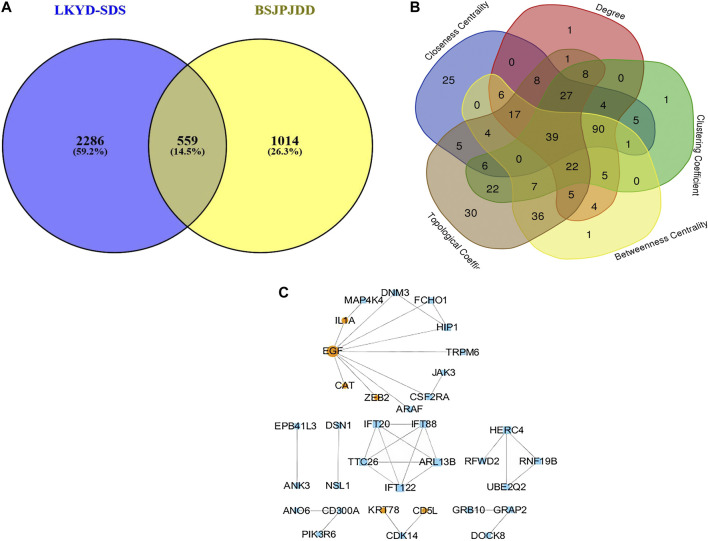
Venn analysis and network pharmacology analysis of BSJPJDD in CRC patients with LKYD-SDS. (A) Venn Analysis, (B) Network Topological analysis, (C) targets networks BSJPJDD.